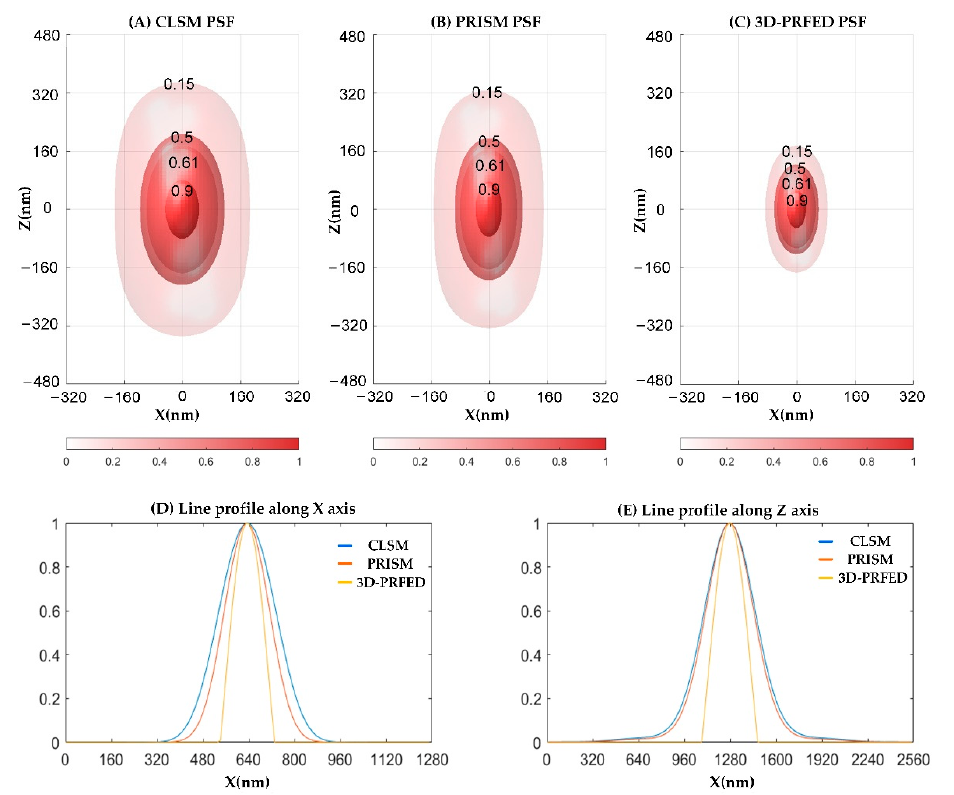
Figure 3. The effective PSF comparison among CLSM, PRISM, and 3D-PRFED. ( A ) The front view of CLSM PSF, 0.9, 0.61, 0.5, 0.15 is the corresponding value of their contour plane. ( B ) The front view of PRISM PSF. ( C ) The front view of 3D-PRFED PSF. ( D ) The cross-section profile comparison among CLSM, PRISM and 3D-PRFED along the x axis. ( E ) The cross-section profile comparison among CLSM, PRISM and 3D-PRFED along the z axis. The excitation light wavelength in this simulation is 640 nm and the Stokes shift wasn’t considered. The diameter of the detector array is one AU.